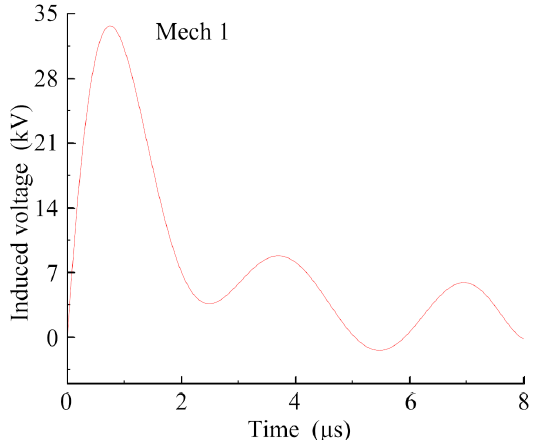
Figure 12. Induced voltage in mesh 1 under +10/350 µ s and 100 kA.